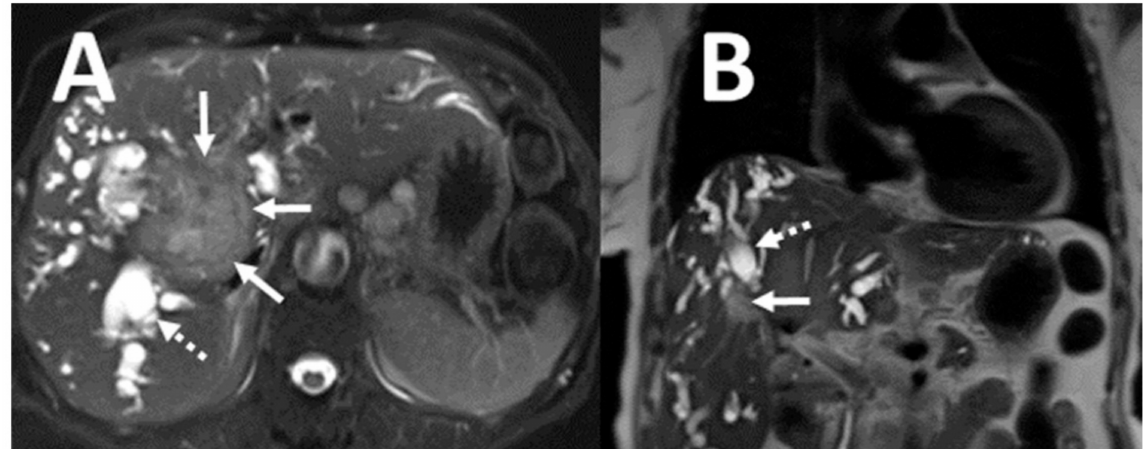
Figure 2. Example of clinically significant non-cardiac abnormality on CMR. Unexpectedly found hilar cholangiocarcinoma ( A , B : solid arrows) with intrahepatic bile duct dilatation ( A , B : dashed